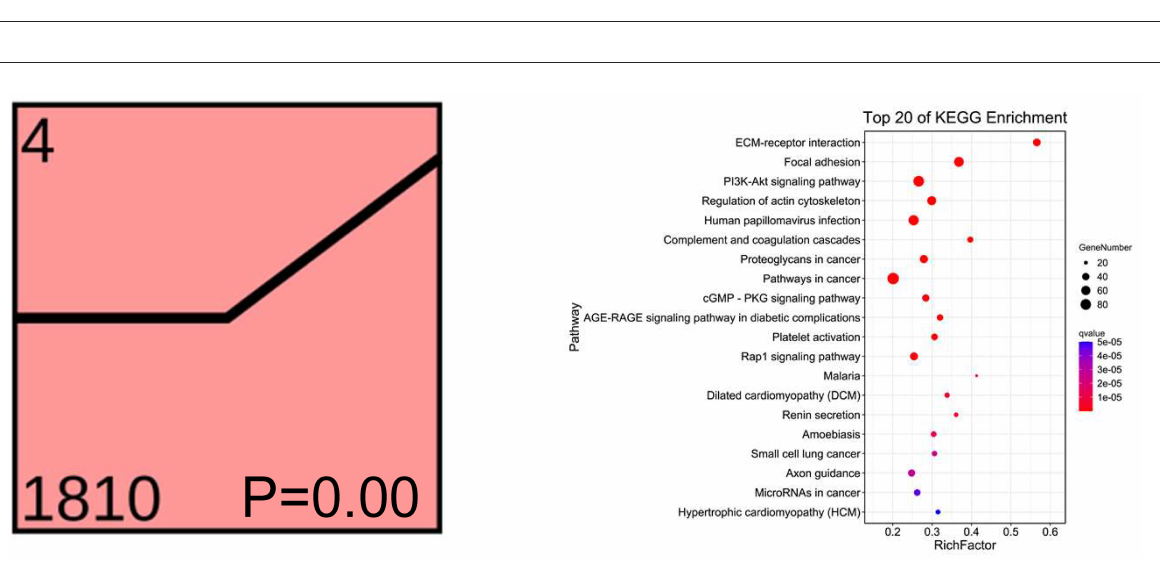
FIGURE6 The dynamics of the rumen epithelial transcriptomic analysis of significant DEGs in Profile 4 under different feeding strategies. The top 20 KEGG pathways for Profile 4 are listed on the right. X -axis depicts the richness factor (Richness factor = DEGs enriched in the pathway/background genes in the pathway). Y -axis represents the KEGG pathway terms. G, natural grazing; T, semi-grazing with supplementation; F, barn